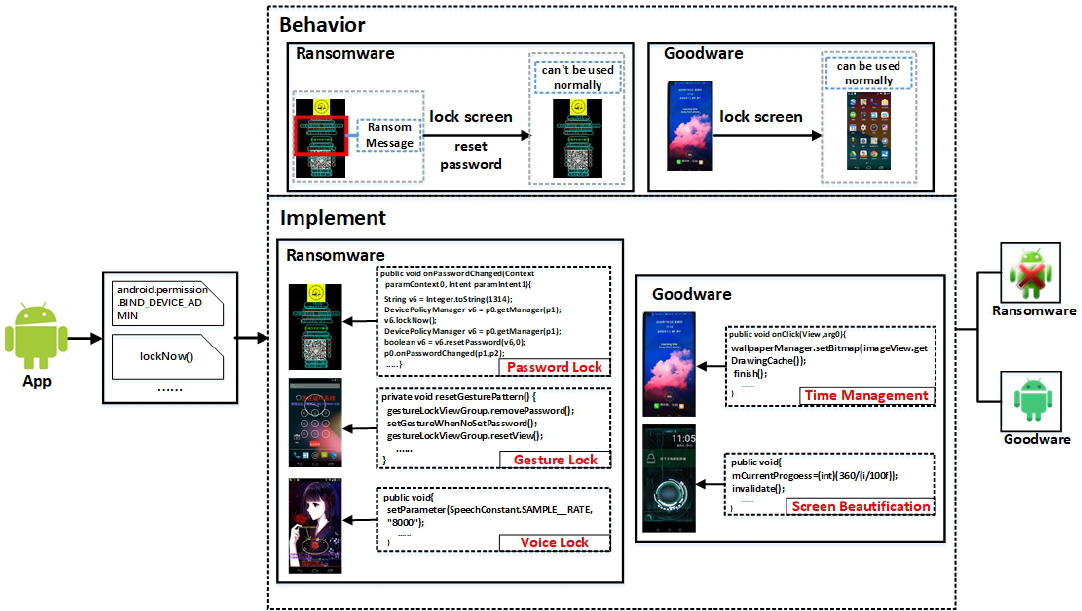
Figure 2. Differences between device lock ransomware and goodware